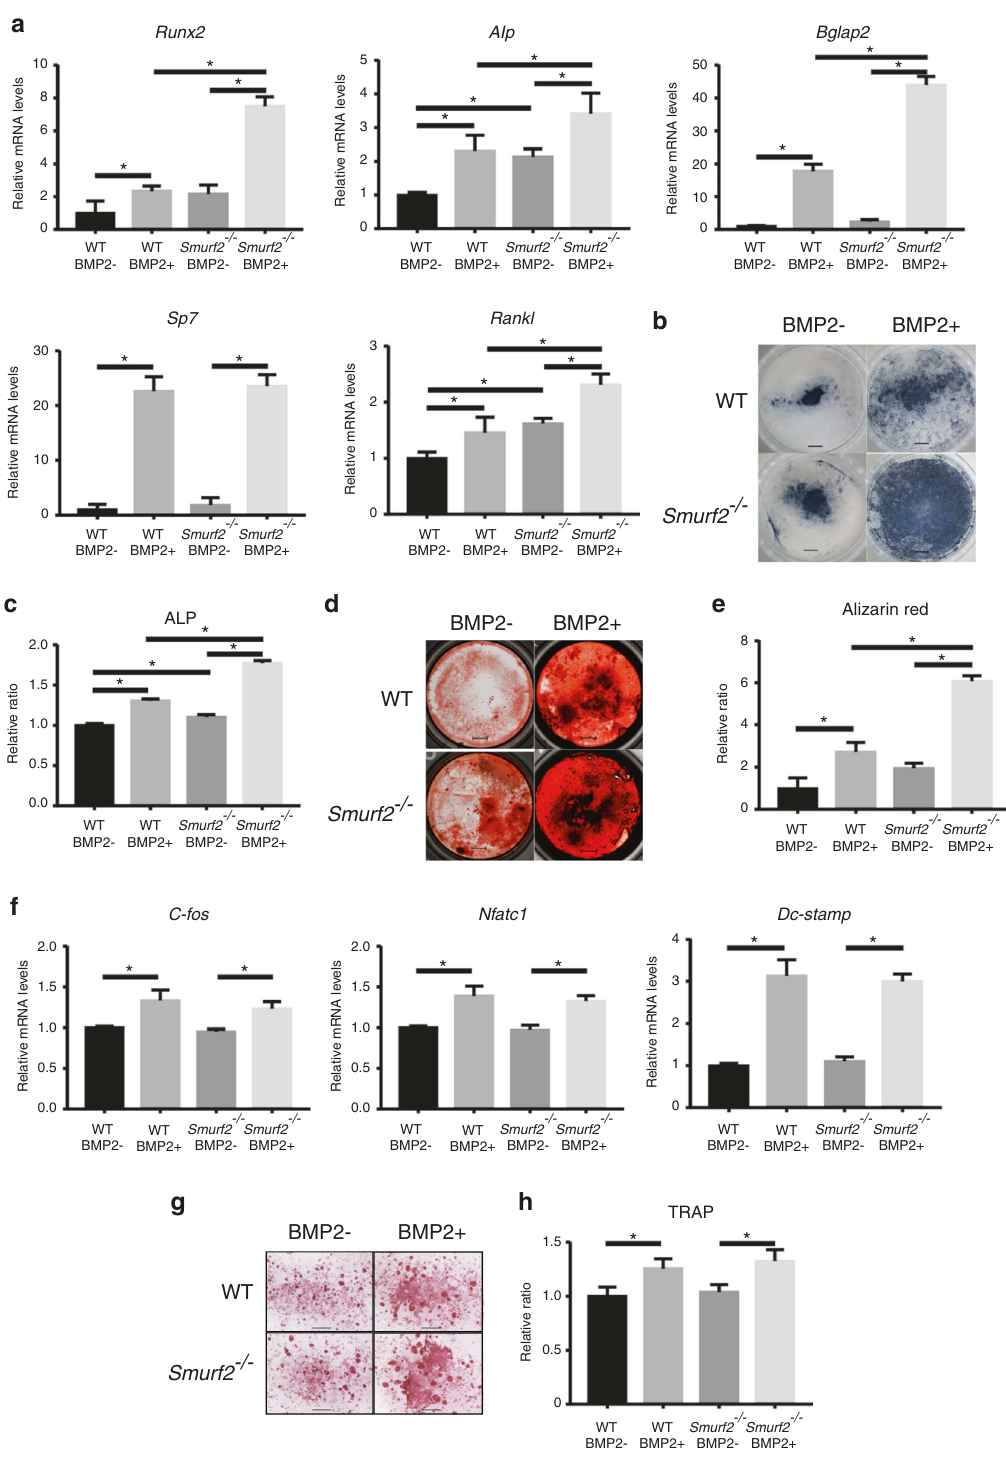
Fig. 5 In vitro osteogenic and osteoclastic differentiation assays. a Quantitative real-time PCR analysis of BMSCs cultured in osteogenic medium with or without rhBMP2. b , c ALP staining of BMSCs cultured in osteogenic medium with or without rhBMP2 (scale bar = 2 mm). d , e Alizarin red staining of BMSCs cultured in osteogenic medium with or without rhBMP2 (scale bar = 2 mm). f Quantitative real-time PCR analysis of osteoclasts cultured in osteoclastogenic medium with or without rhBMP2. g , h TRAP staining of osteoclasts cultured in osteoclastogenic medium with or without rhBMP2. (scale bar = 1 mm). ( n = 3 per group; * P < 0.05 by one-way ANOVA followed by the Bonferroni between homeostatic bone metabolism in skeletal bone and the rhBMP2-induced ectopic bone formation model, which re fl ects process of rapid ectopic bone formation. rapid bone formation, showed that ectopic new bone mass and The discrepancy between the skeletal bone phenotype and the osteoblastic bone formation were increased in Smurf2 − / − mice. results of the osteogenic differentiation assay in Smurf2 − / − mice These fi ndings imply that the impact of Smurf2 de fi ciency differs